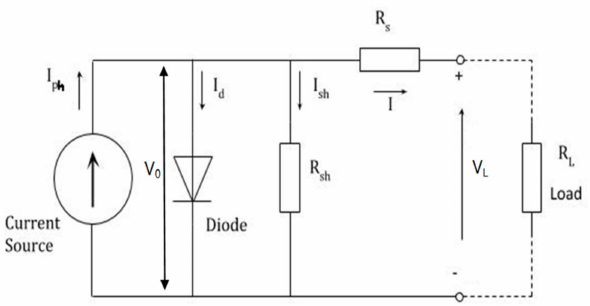
Figure 3. Equivalent circuit (Single diode) of a photovoltaic cell